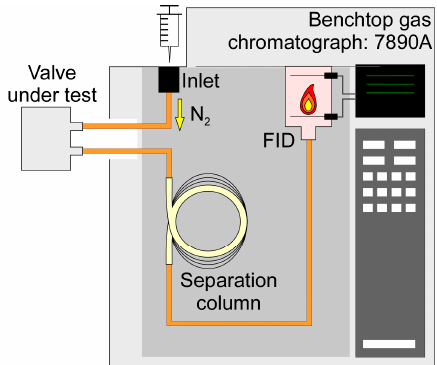
Figure 12. The test setup of the chemical injection tests. The valve under test was connected to the flow path of a benchtop gas chromatograph (7890A, Agilent Technologies Inc., Santa Clara, CA,